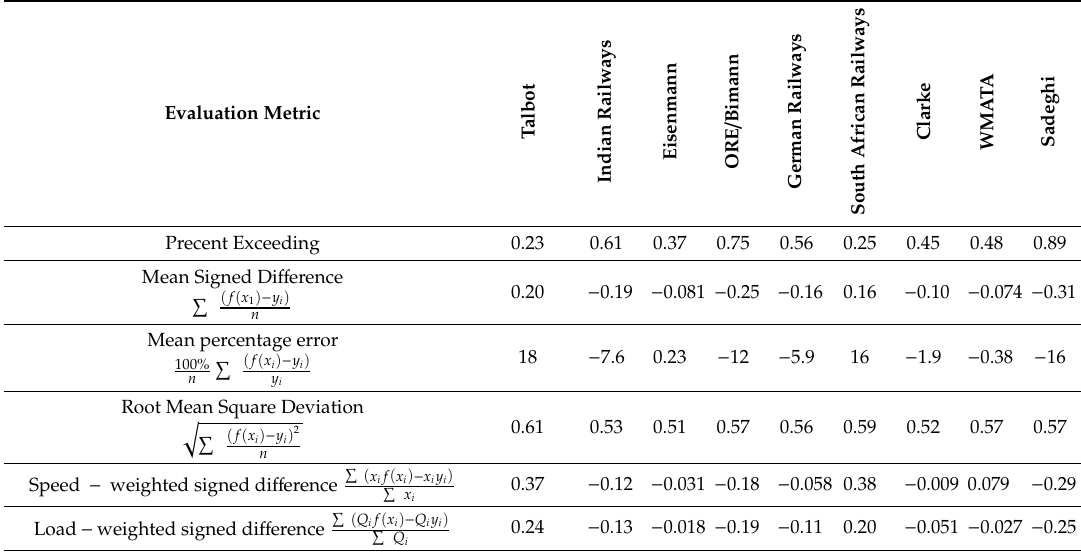
Figure 1. Di ff erent types of existing dynamic factor calculation methods [7]. Figure 1. Different types of existing dynamic factor calculation methods [7] . Table 1. Parametric Comparison of Di ff erent Impact Factor Calculation methods Table 1. Parametric Comparison of Different Impact Factor Calculation methods [7] .